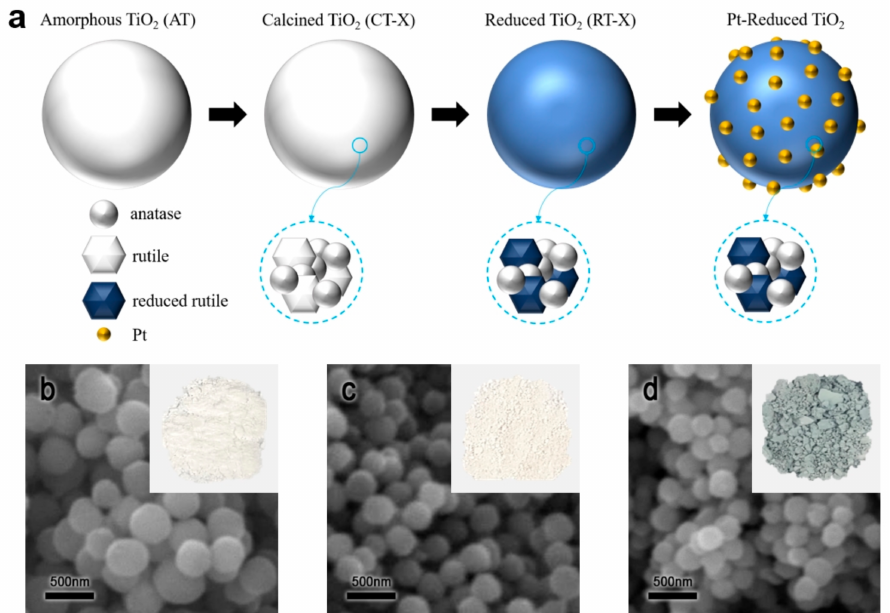
Figure 1. ( a ) Schematic illustration for synthesis of reduced TiO 2 samples (RT-x) and Pt-reduced TiO 2 catalyst. Corresponding SEM and digital images of ( b ) amorphous TiO 2 (AT), ( c ) calcined TiO 2 (CT-x), and ( d ) reduced TiO 2 (RT-x), respectively.